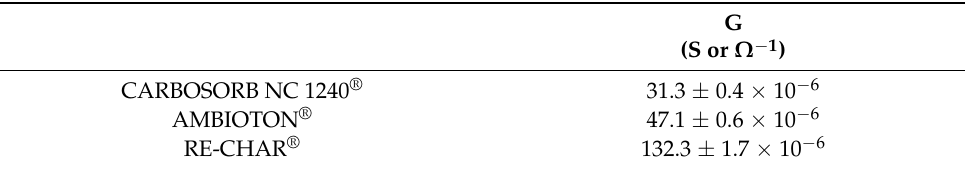
Table 4. Conductivity (G) of the three carbon-based sorbents ( Ω − 1 ).